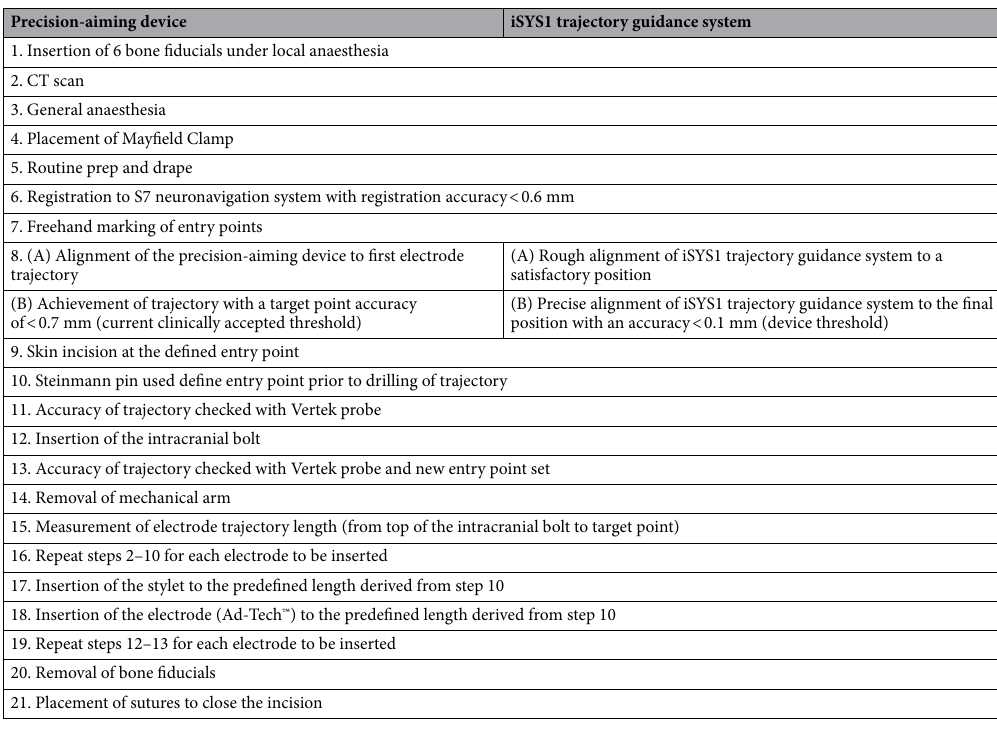
Table 1. Operative steps associated with each implantation